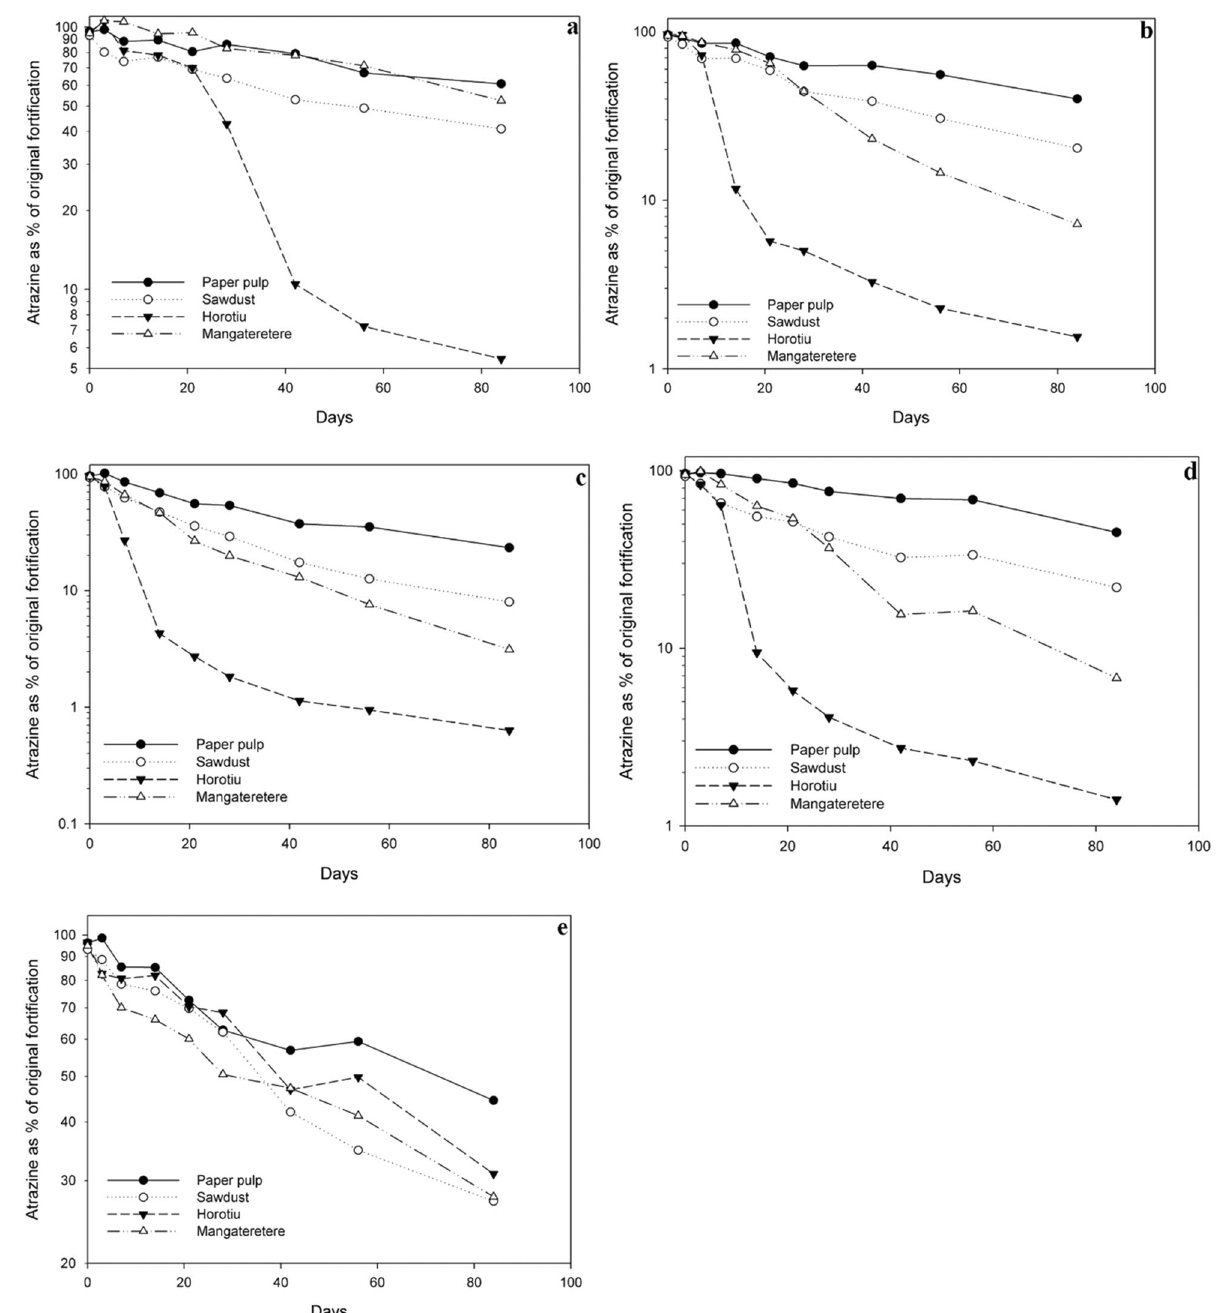
Figure 1. Atrazine degradation at ( a ) 10, ( b ) 20, ( c ) 30, ( d ) 20 ± 5, and ( e ) 20 °C sterilised with semi-log axis. Data points are average of duplicate